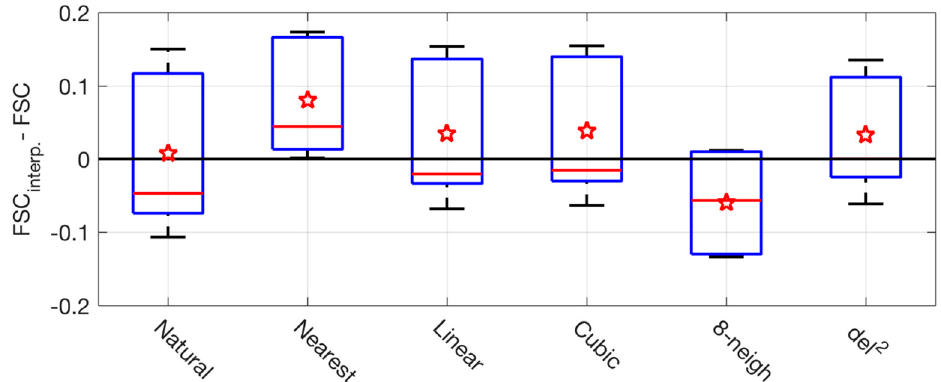
Figure A2. Distributions of the difference between fractional sky coverage (FSC) calculated for the interpolated and non-interpolated regions. One hour of TSI images centered on the five Landsat images are analyzed for different interpolation schemes. The 60-min average “opaque-cloud-only” FSCs are obtained for the interpolated region only (FSC interpolated ) and the original cloud mask only (FSC). Red star and red line show the mean and median values for the difference between FSCs calculated for the interpolated and original images, respectively. Boxes and whiskers define percentiles (25th and 75th) and minimum/maximum values, respectively.